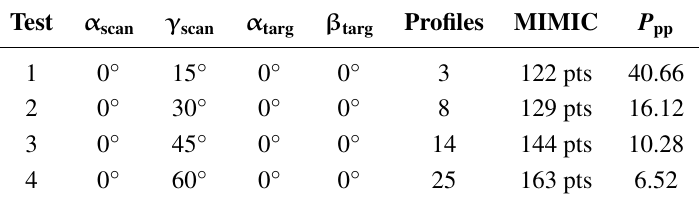
Table 5. The impact of vertical scanner rotations on point and profile distribution for a narrow vertical target of dimensions 0.1 m × 2 m at a horizontal range of 5 m.